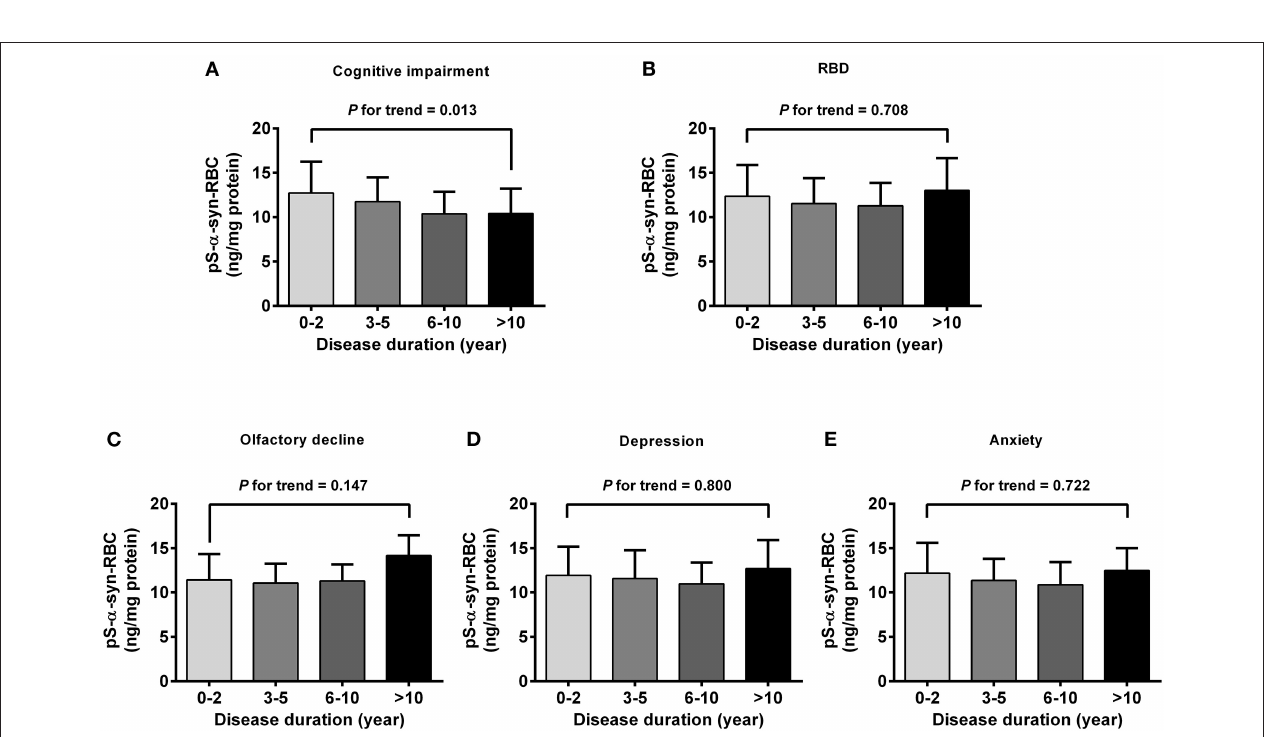
FIGURE 4 | Correlations of pS- α -syn-RBC with disease duration in PD patients with different non-motor subtypes. Correlations between pS- α -syn-RBC and intervals of disease duration in PD patients with non-motor subtypes was analyzed by using one-degree-freedom linear term for trend analysis. (A) Cognitive impairment; (B) RBD; (C) olfactory loss; (D) depression; (E) anxiety. p -values for the changing trend of pS- α -syn-RBC levels across increased disease durations were calculated.